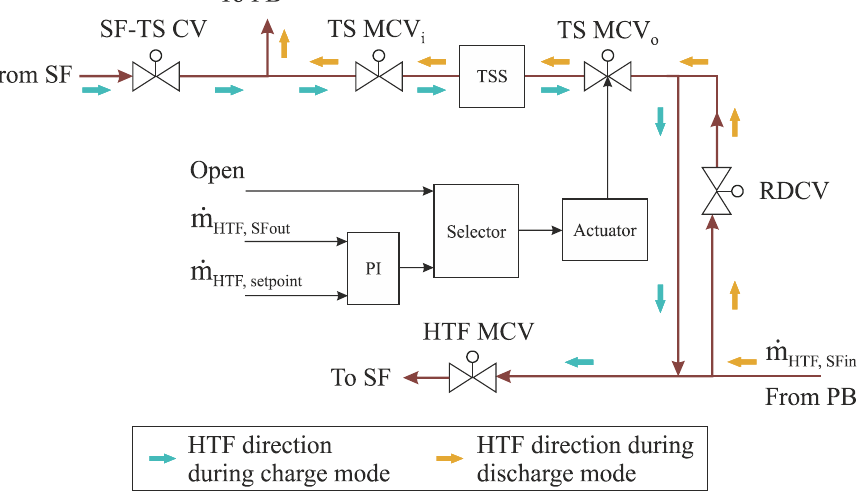
Figure 11. HTF control valve at the thermal storage outlet (simplified).